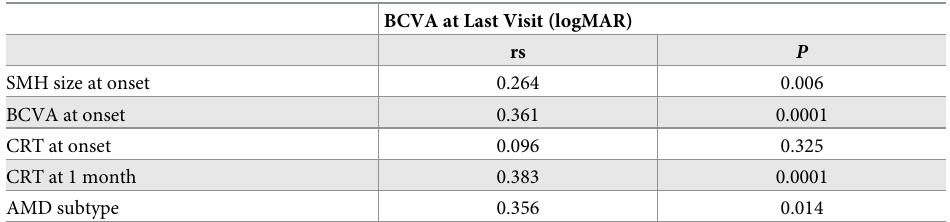
rs = Pearson’s rank correlation coefficient; BCVA = best-corrected visual acuity; logMAR = logarithm of the minimum angle of resolution; SMH = submacular hemorrhage; CRT = central retinal thickness; AMD = age-related macular